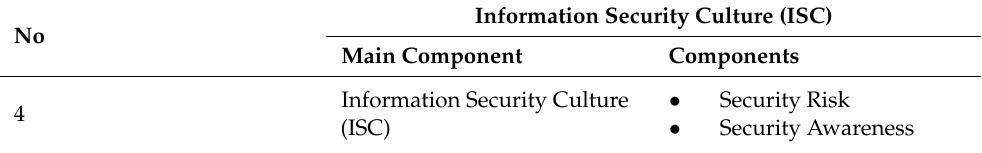
Table 4. Information Security Culture